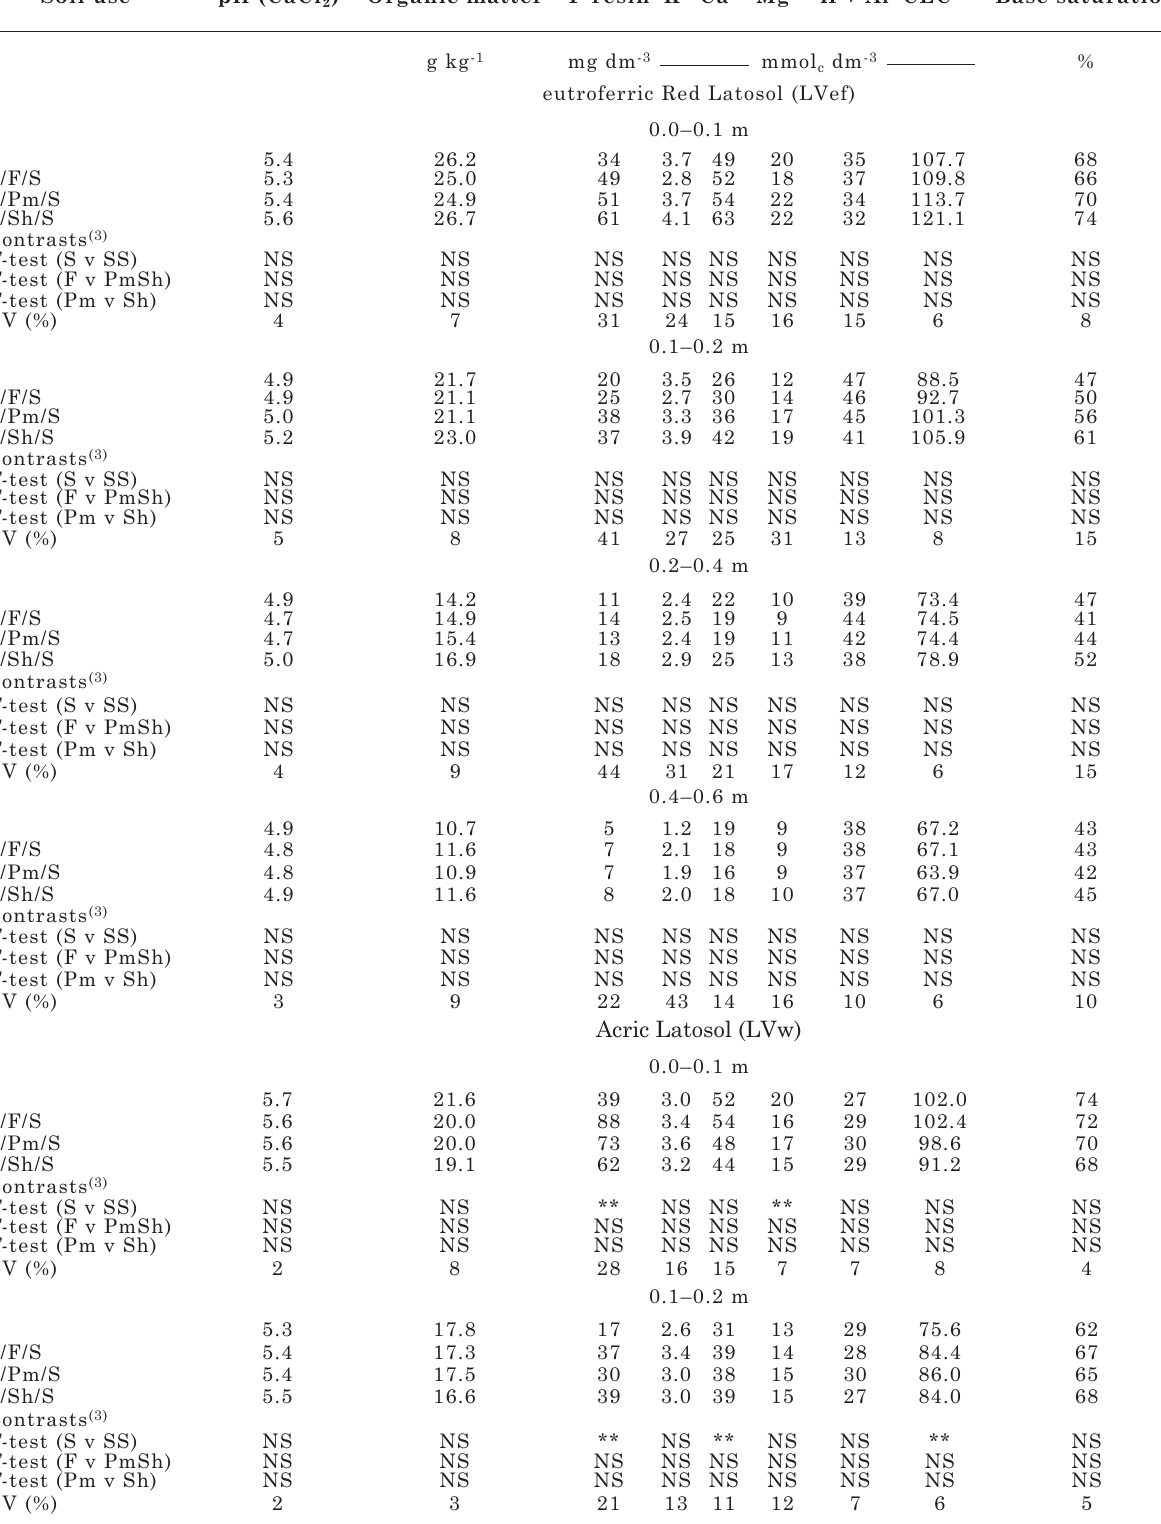
table 7. Soil chemical properties at different soil layer at the end of the experiment, and significance of the